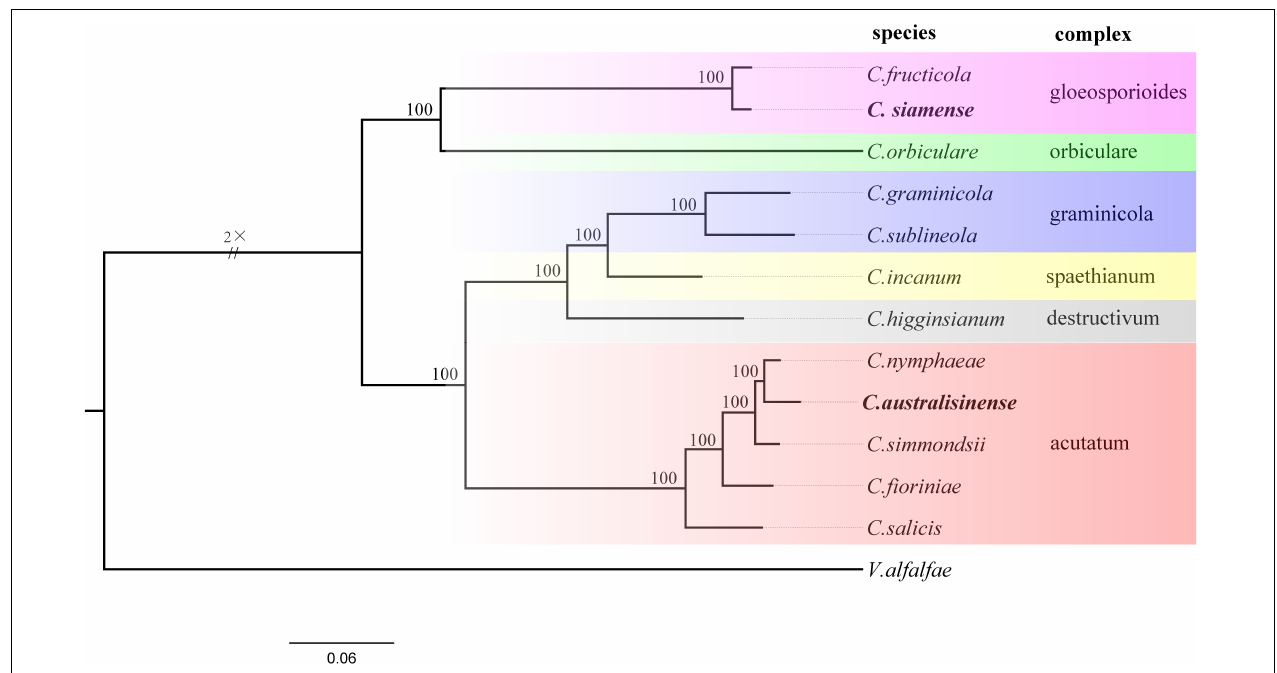
FIGURE 2 | Phylogenetic tree based on single-copy orthologous genes of different Colletotrichum species, with Verticillium alfalfae as the outgroup to root the tree. All branches have 100% bootstrap support values. Two Colletotrichum species in this study are in bold.